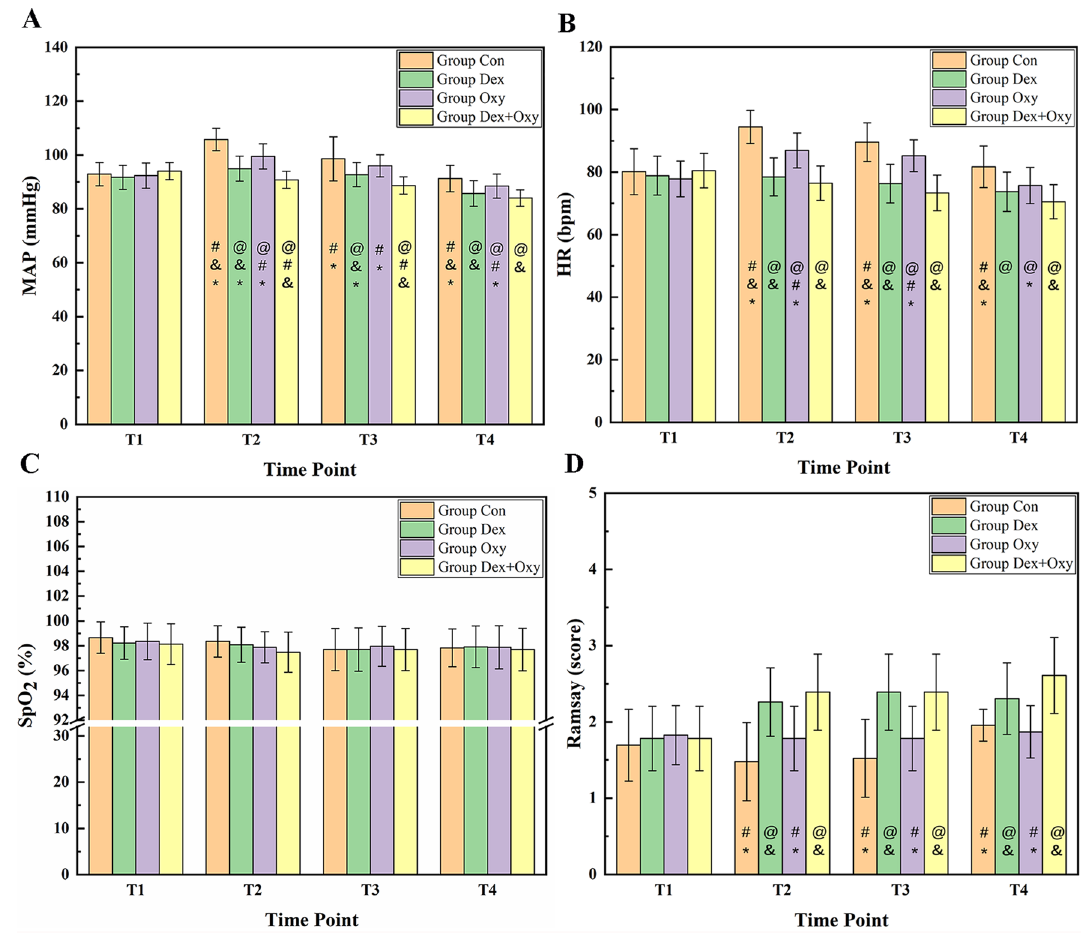
Figure 1. The results of MAP ( A ), HR ( B ), SpO2 ( C ), and Ramsay score ( D ) at T1-T4 in Con Group, Dex Group, Oxy Group, and Dex + Oxy Group. "@", "#", "&", "*" represent the difference was statistical when compared with Con Group, Dex Group, Oxy Group, and Dex + Oxy Group, respectively.